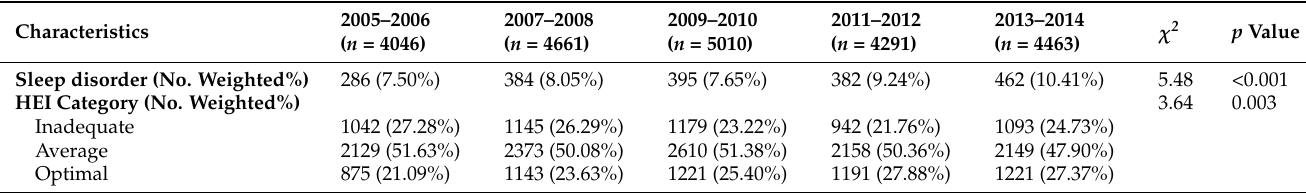
Figure 2. The trend of HEI-2015 scores in the five cycles from NHANES 2005–2014. The white points in the graph represent the weighted mean of the HEI-2015 scores for each study wave. Table 1. Characteristics of adults aged 20+ years in NHANES